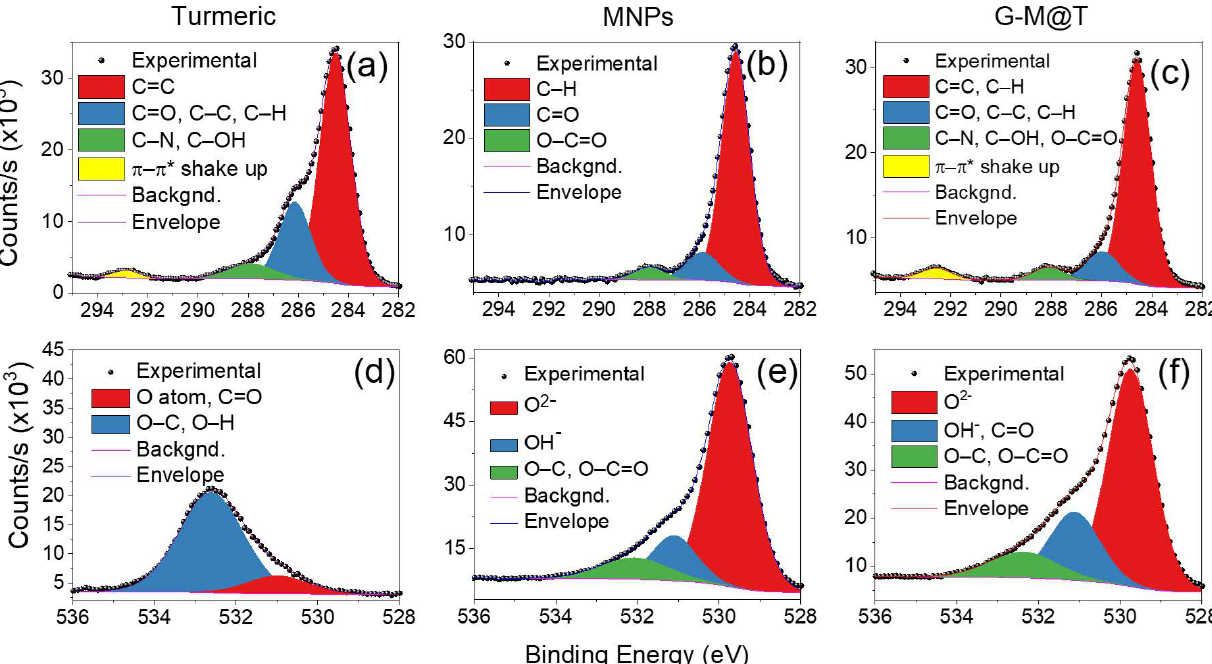
Figure 2. High-resolution XPS spectra of the C 1s ( a – c ) and O 1s ( d – f ) orbitals for turmeric powder, MNPs, and G-M@T